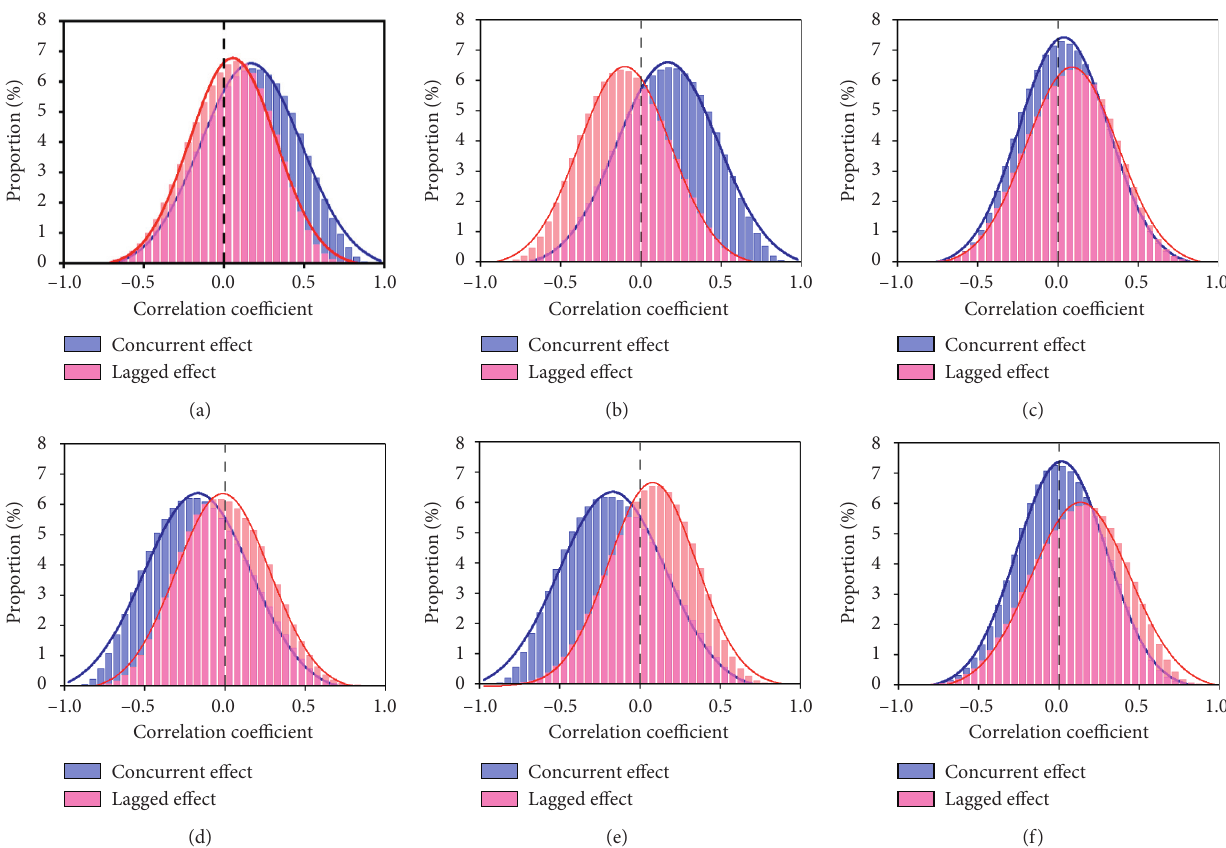
Figure 11: The lag response of NDVI to precipitation and air temperature in different seasons. (a) The lag effect of spring precipitation on summer NDVI; (b) the lag effect of spring precipitation on autumn NDVI; (c) the lag effect of summer precipitation on autumn NDVI; (d) the lag effect of spring air temperature on summer NDVI; (e) the lag effect of spring air temperature on autumn NDVI; (f) the lag effect of summer air temperature on autumn NDVI.